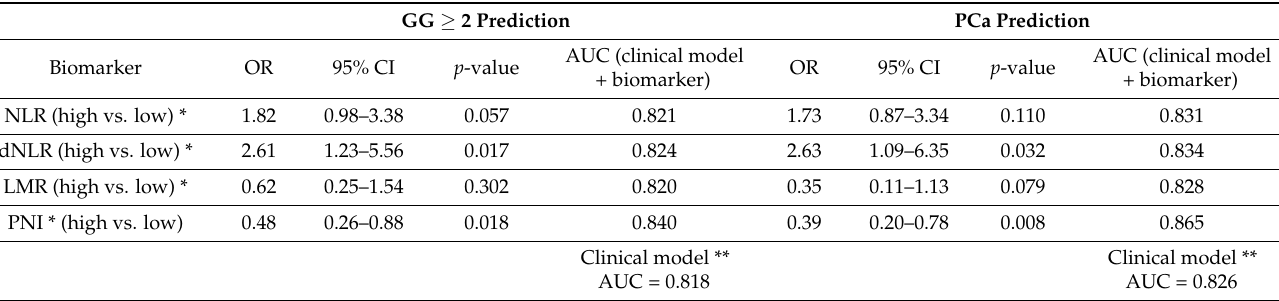
Table 2. Consecutive patients with PI-RADS ≥ 3 lesions undergoing MRI-targeted and systematic biopsy stratified by PI-RADS and cancer status.